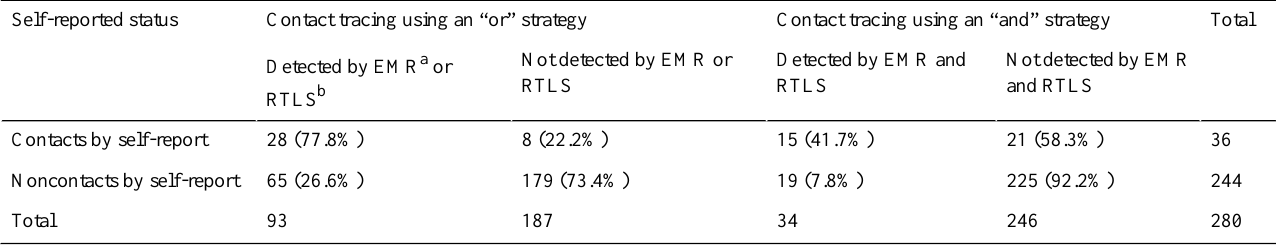
Table 5. Comparison of two different approaches to combining EMR and RTLS data versus self-reported contacts with patients with COVID-19. Percentages are calculated according to row